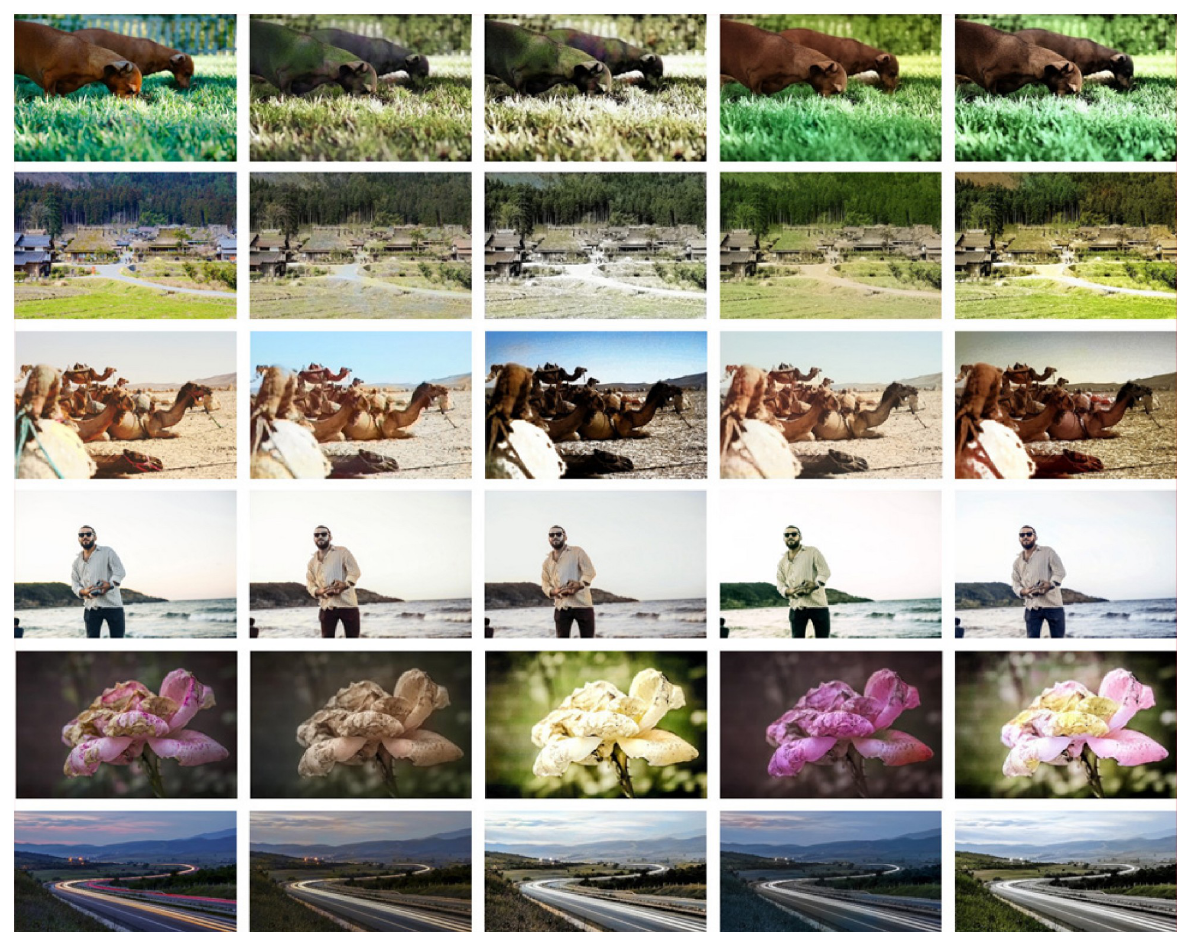
Fig 6. The effect of HE on image colorization. From top to bottom: two normal exposure image, two overexposed images, two underexposed images. From left to right: the ground truth, the coloring effect of Iizuka et al. [16] (the original method), the coloring effect of Iizuka et al. [16] with histogram equalization(the improved method), the coloring effect of ours without histogram equalization, and the coloring effect of ours with histogram equalization.(HE = histogram equalization). (a) GT, (b) [16], (c) [16] + HE, (d) Ours—HE, (e) Ours.